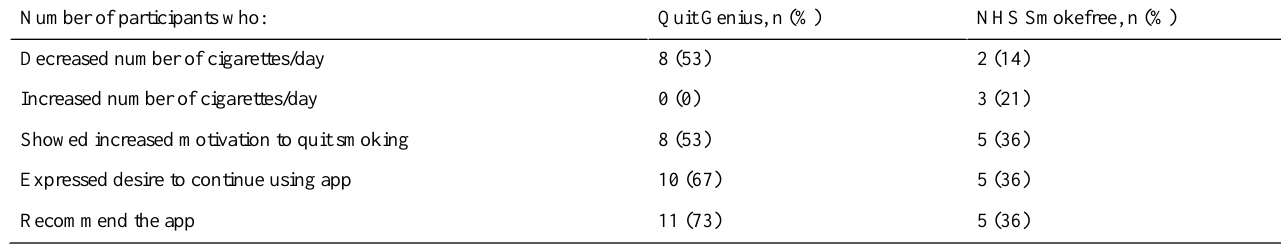
Table 4. Overall patterns of users’perceptions and health behavior change in relation to smoking cessation for each